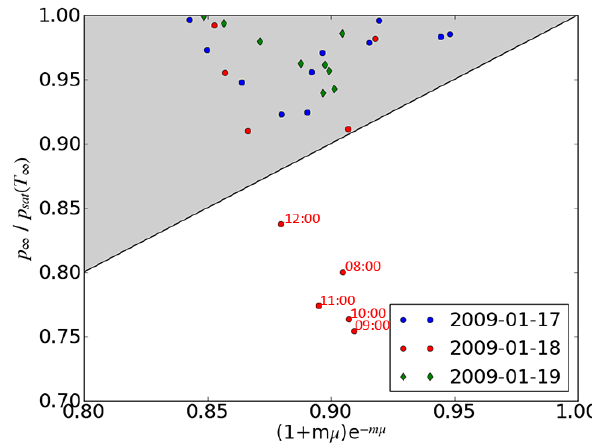
Figure 5. Schematic diagram of temperature and water vapor pres- sure for the air–snow system. The figure is adapted from Fig. 2 of Style and Worster (2009). The snow temperature is simulated by Crocus on 18 January at 11:00LT. The blue and red dots and the blue diamond are calculated from 4m measurements. The T , water vapor pressure and saturation pressure profiles between the snow surface and 4m height are drawn from Fig. 2 of Style and Worster (2009).